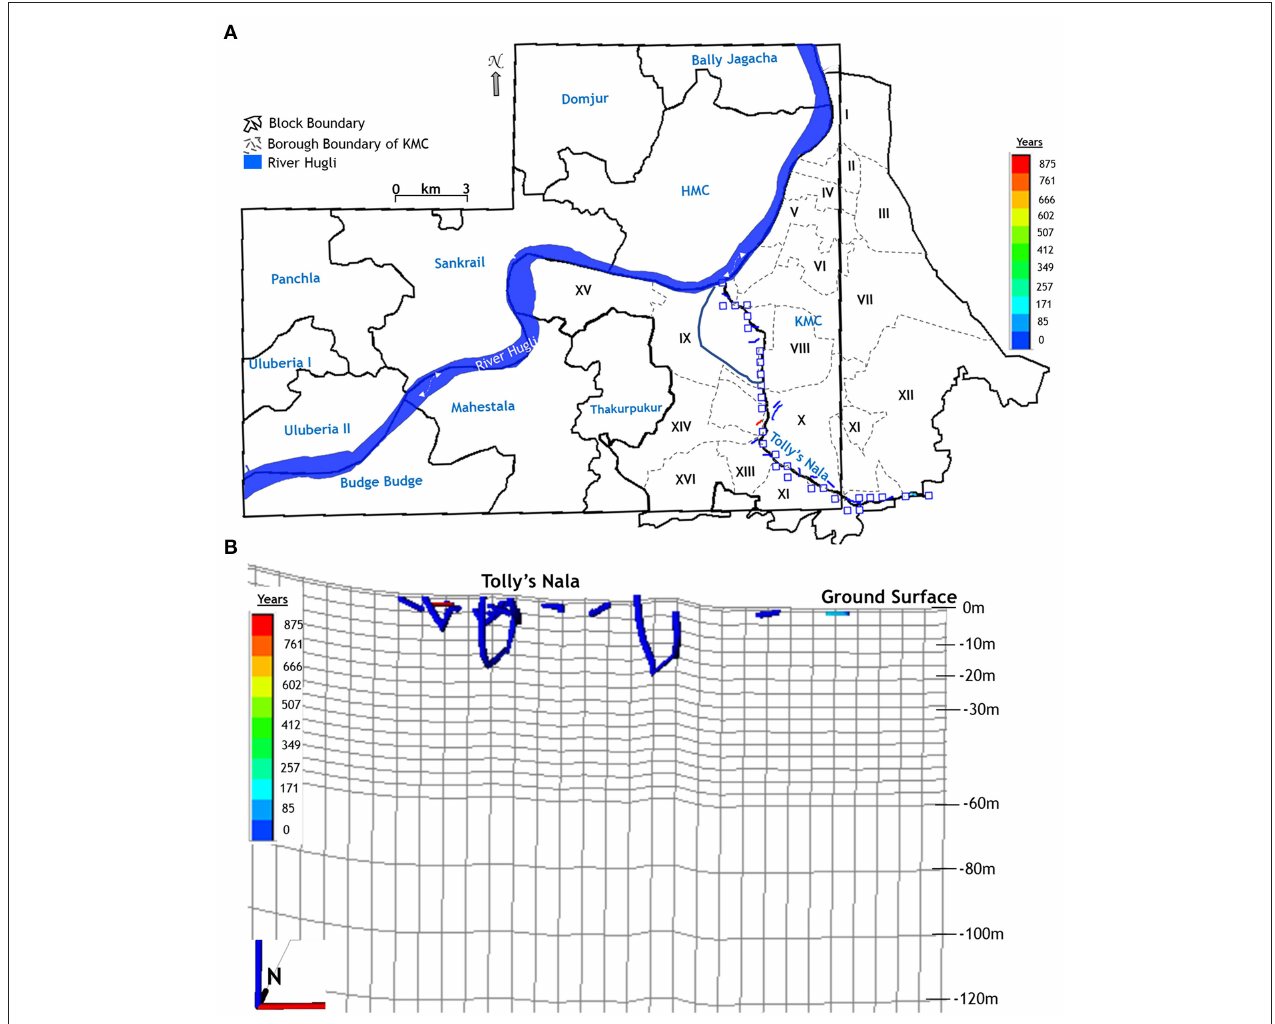
FIGURE 10 | (A) Path lines of forward tracked particle under predevelopment pumping conditions. (B) 3-D view of particle path lines from Tolly’s Nala (recharge area) into the aquifer under predevelopment conditions; vertical exaggeration is 75x.